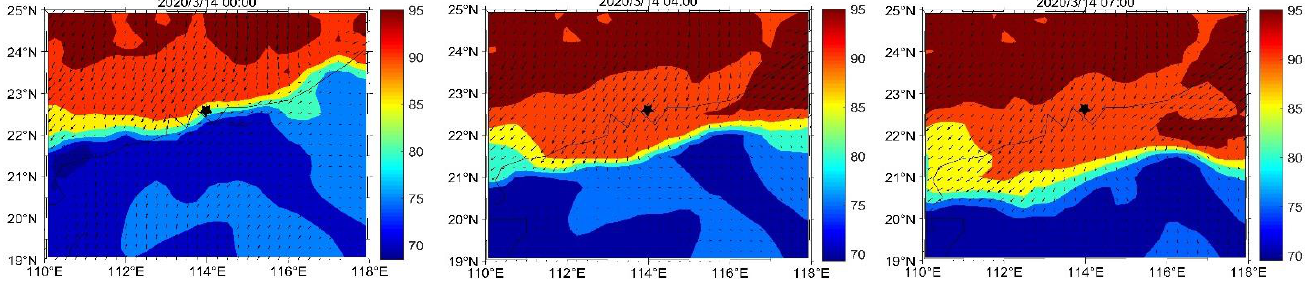
Figure 7. Geographical distribution of the composites of 950 hPa O 3 concentration (units: μg/m 3 ; shaded colours) and 950 hPa horizontal wind vectors at 00:00, 04:00, 07:00 on 14 March 2020, re- spectively (data from the ECMWF). The black pentagram is the location of the ozone profile. Therefore, the entire night O 3 pollution event can be explained by Figure 8, during which the LLJ played an important role. In the horizontal direction, the LLJ efficiently transported the inland airmass with rich O 3 to the coastal areas. At the same time, due to the strong vertical shear of wind speed caused by LLJ, the turbulence in the surface layer was enhanced, so that the O 3 at high altitudes was delivered to the ground through ver- tical exchange.